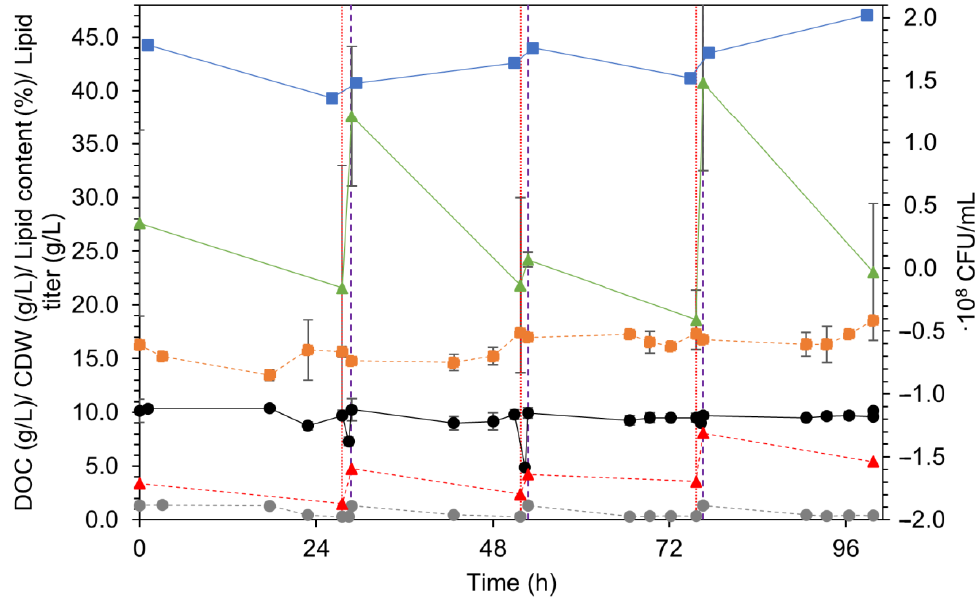
Figure 1. (-- ■ --) Cell dry weight (CDW), (- ● -) total dissolved organic carbon DOC, (-- ● --) monomeric DOC as measured by HPLC, (-- ▲ --) lipid titer, (- ▲ -) lipid content, and (- ■ -) CFU for the repeated batch experiment with R. kratochvilovae . Vertical lines (···) indicate the start of the harvest of the cells. Vertical lines (- - -) indicate the end of the harvest and the start of the second, third, and fourth cycle. Error bars represent the standard deviation of three analytical repeats, except for the CFU, where only two analytical repeats were performed. The monomeric substrate concentrations were measured once.